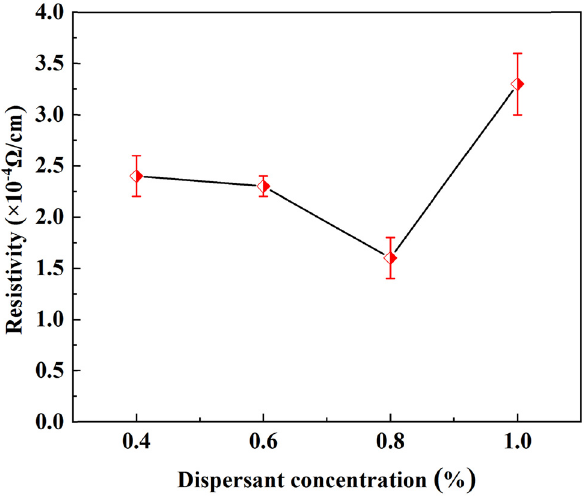
Figure 8: E ff ect of di ff erent dispersant addition on volume resistivity of fl ake silver powder.